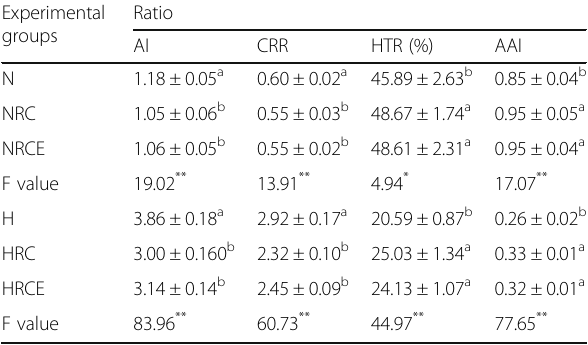
Table 3 Effect of diets on lipidemic ratio Experimental